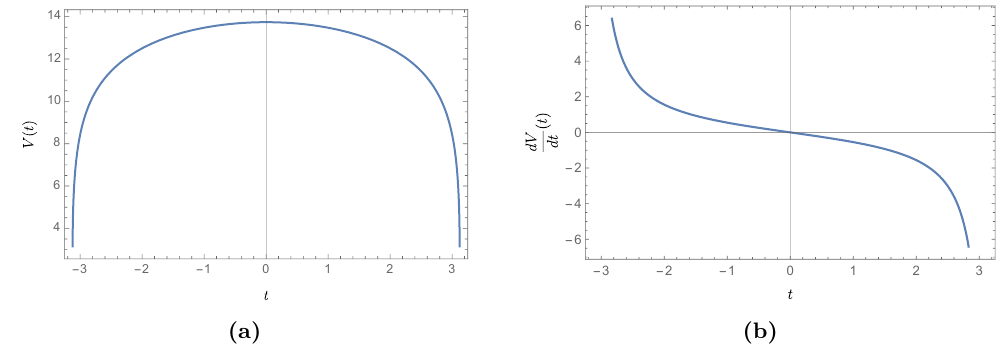
Figure 7. Volume and its time derivative as a function of the boundary time t for the centaur geometry with R b = 100